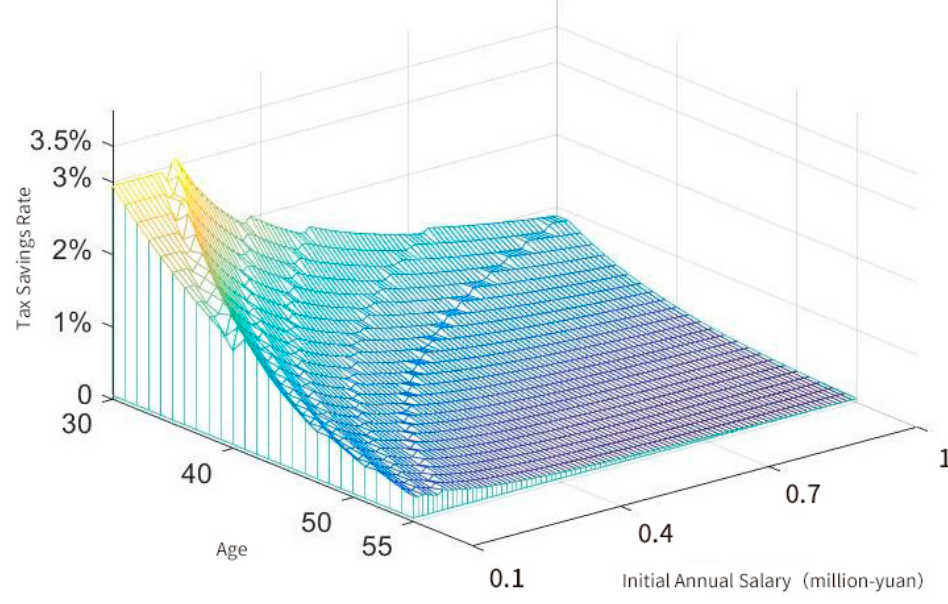
Figure 5. Changes in TSR for 30-year-old insured women under different initial insured annual salaries.